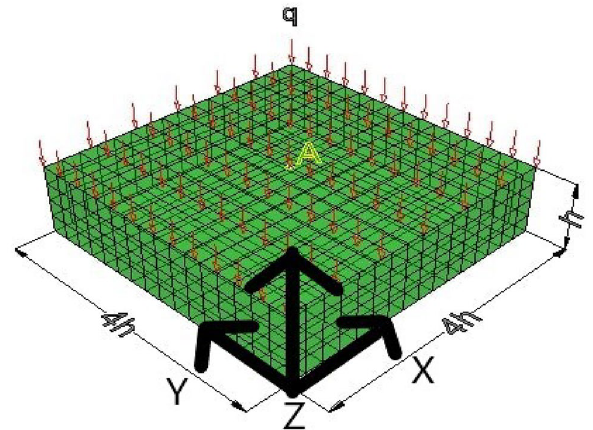
Fig. 5 Geometry of the problem (h=20, 40, 50 m)